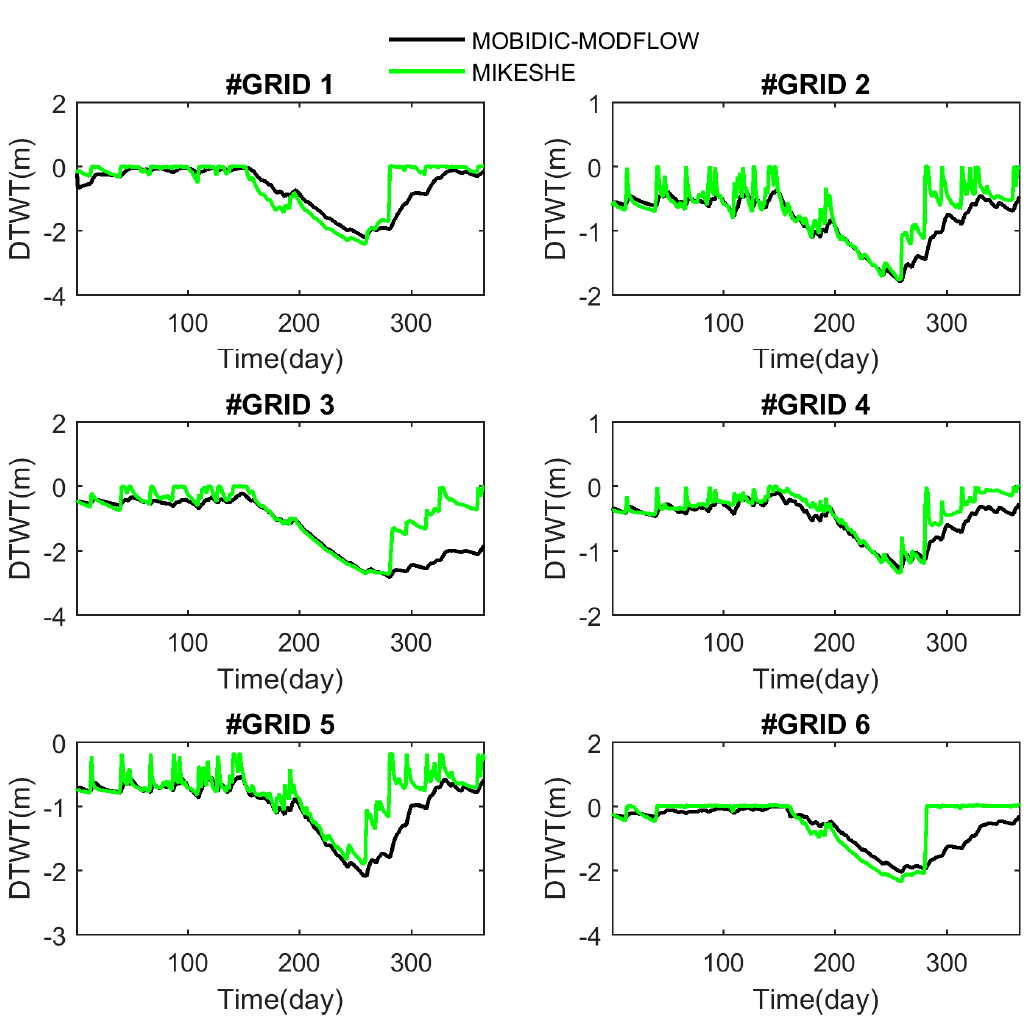
Figure 14. Simulated water table fluctuation at six shallow water table grids with MIKE SHE (green) and MOBIDIC-MODFLOW (black). DTWT stands for depth to water table.